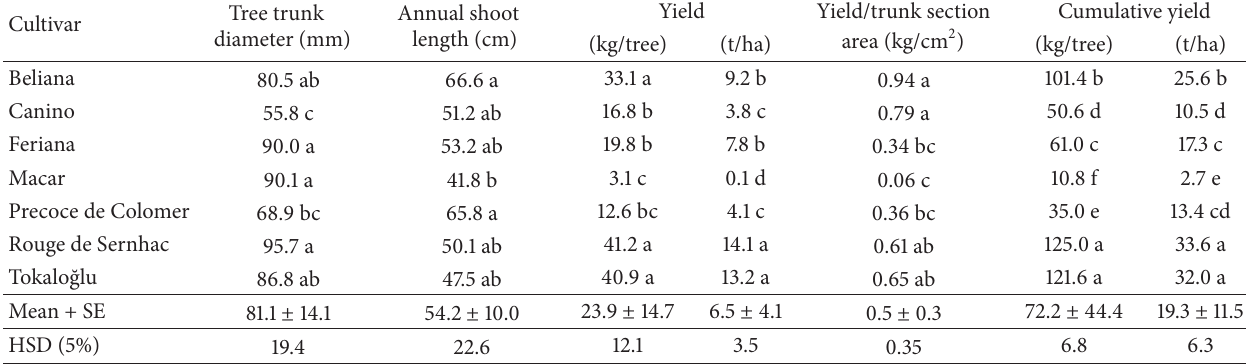
Table 2: Tree trunk diameter, annual shoot length, and yield parameters of the apricot cultivars (average of four years). Tree trunk Cultivar